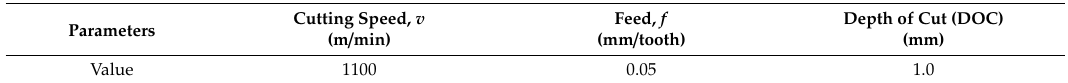
Table 1. Selected milling